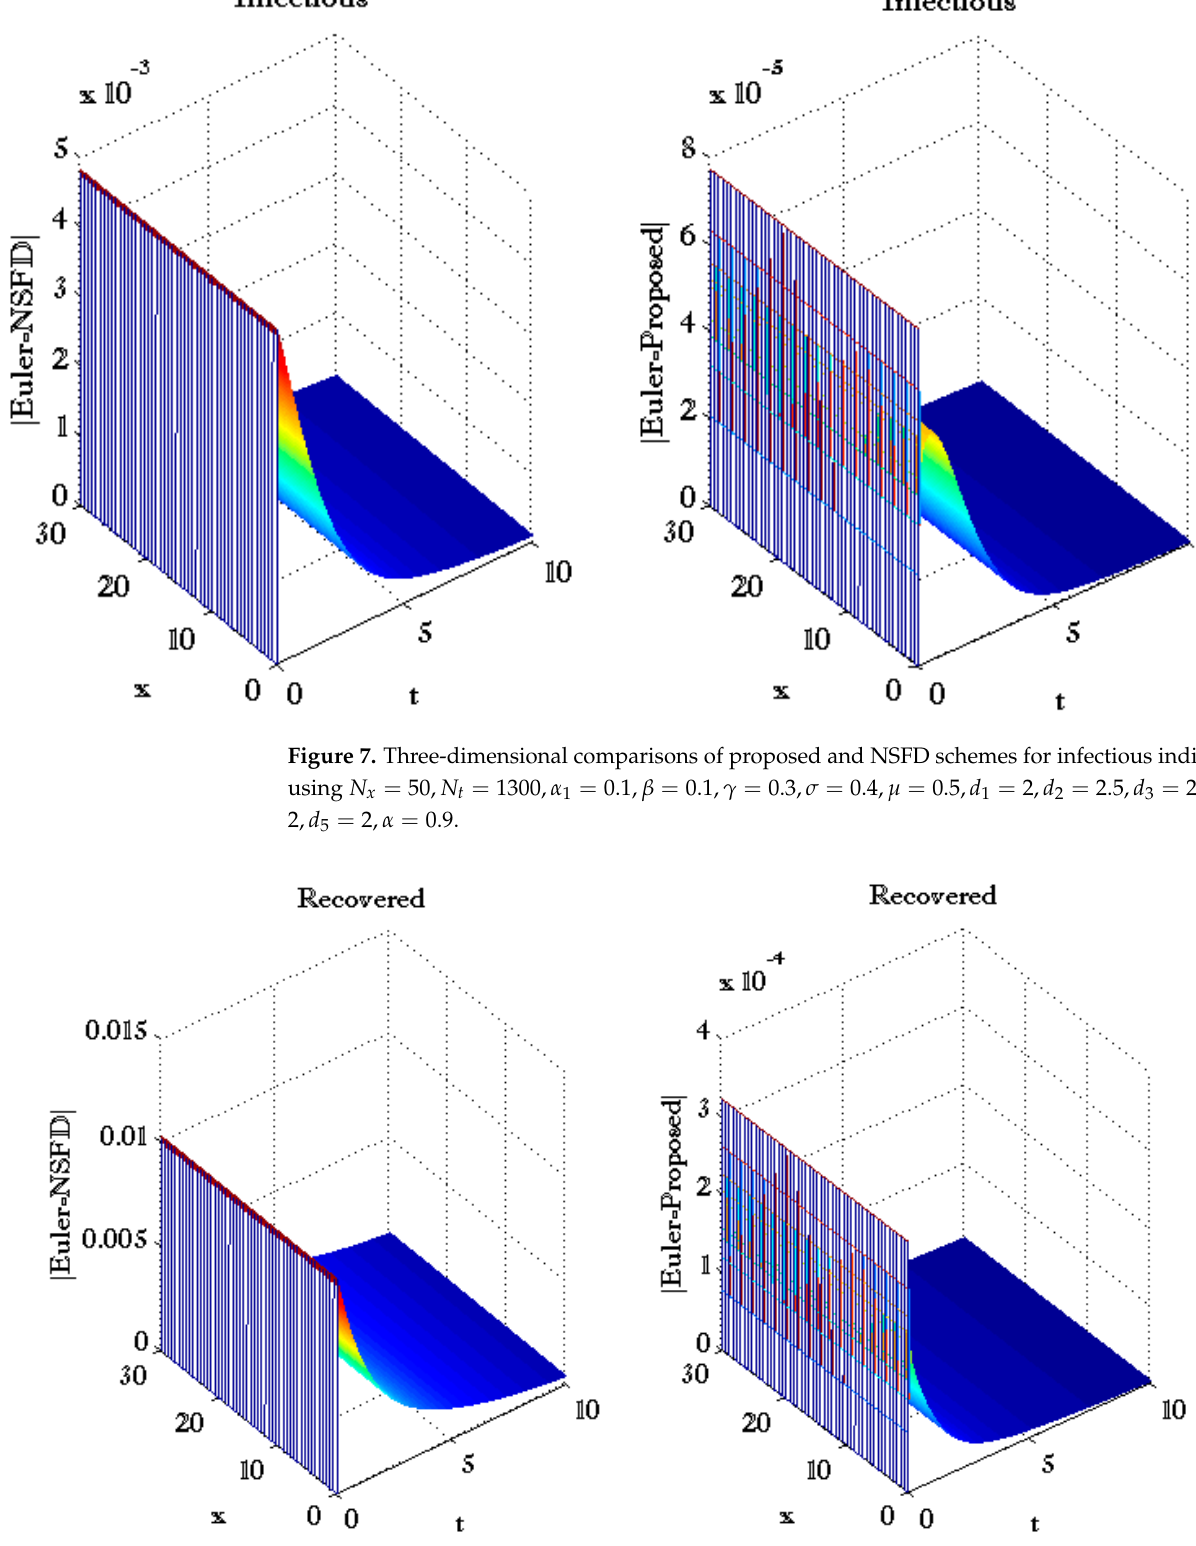
Figure 8. Three-dimensional comparisons of proposed and NSFD schemes for recovered individuals using N x = 50, N t = 1300, α 1 = 0.1, β = 0.1, γ = 0.3, σ = 0.4, µ = 0.5, d 1 = 2, d 2 = 2.5, d 3 = 2.5, d 4 = 2, d 5 = 2, α =